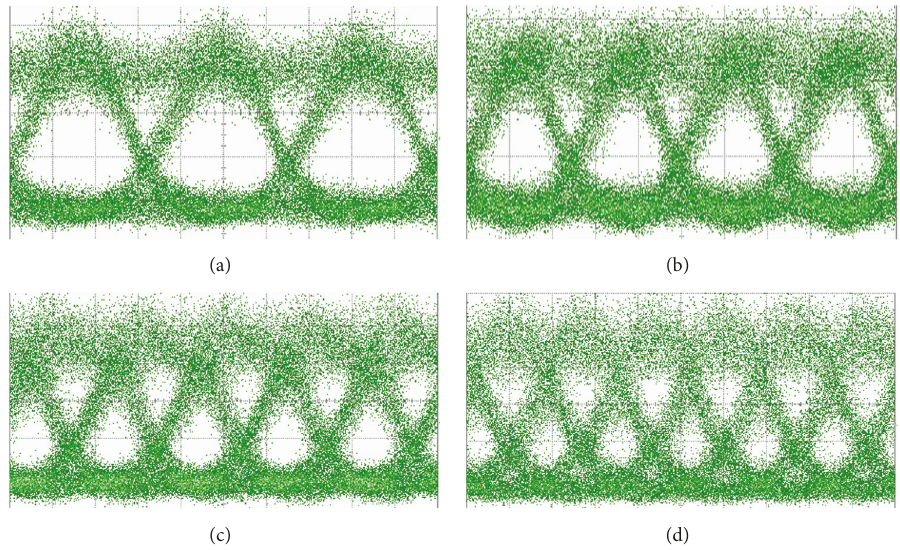
Figure 10: Eye diagram after 5 m wireless transmission when data rates are (a) 3, (b) 4, (c) 5, and (d)